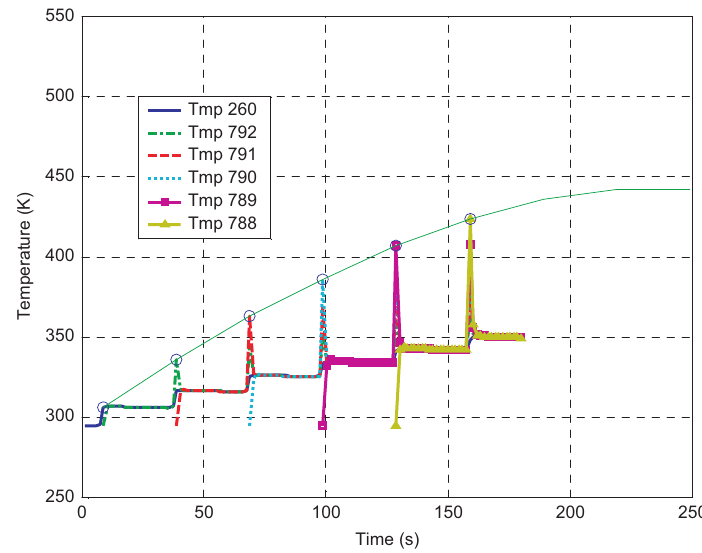
Figure 13 Temperature change at nodes 260, 792 – 788 along radial direction at the angle of 103.5 ° during 180 s (i.e., six rotations at 2 rpm), these nodes are shown in Figure 7.